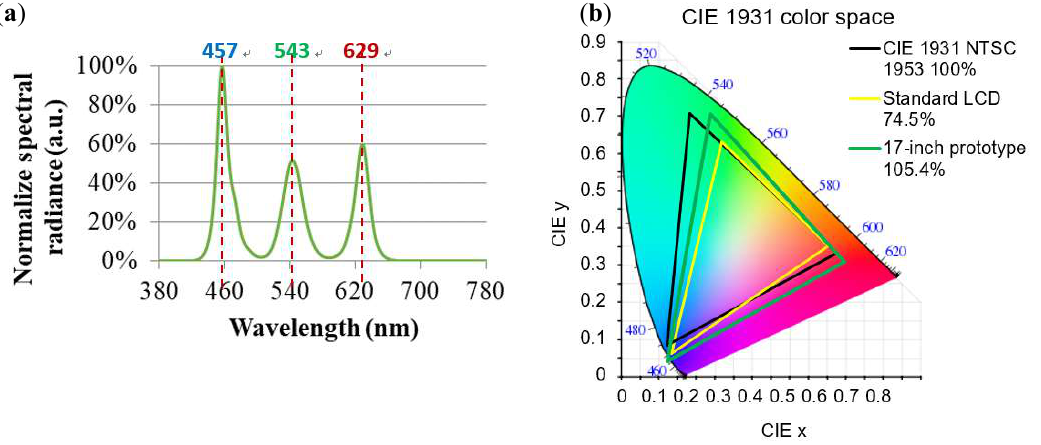
Figure 22. ( a ) Normalized emission spectrum and ( b ) color gamut of an extra-thin, large-area, high-luminance surface light source module.